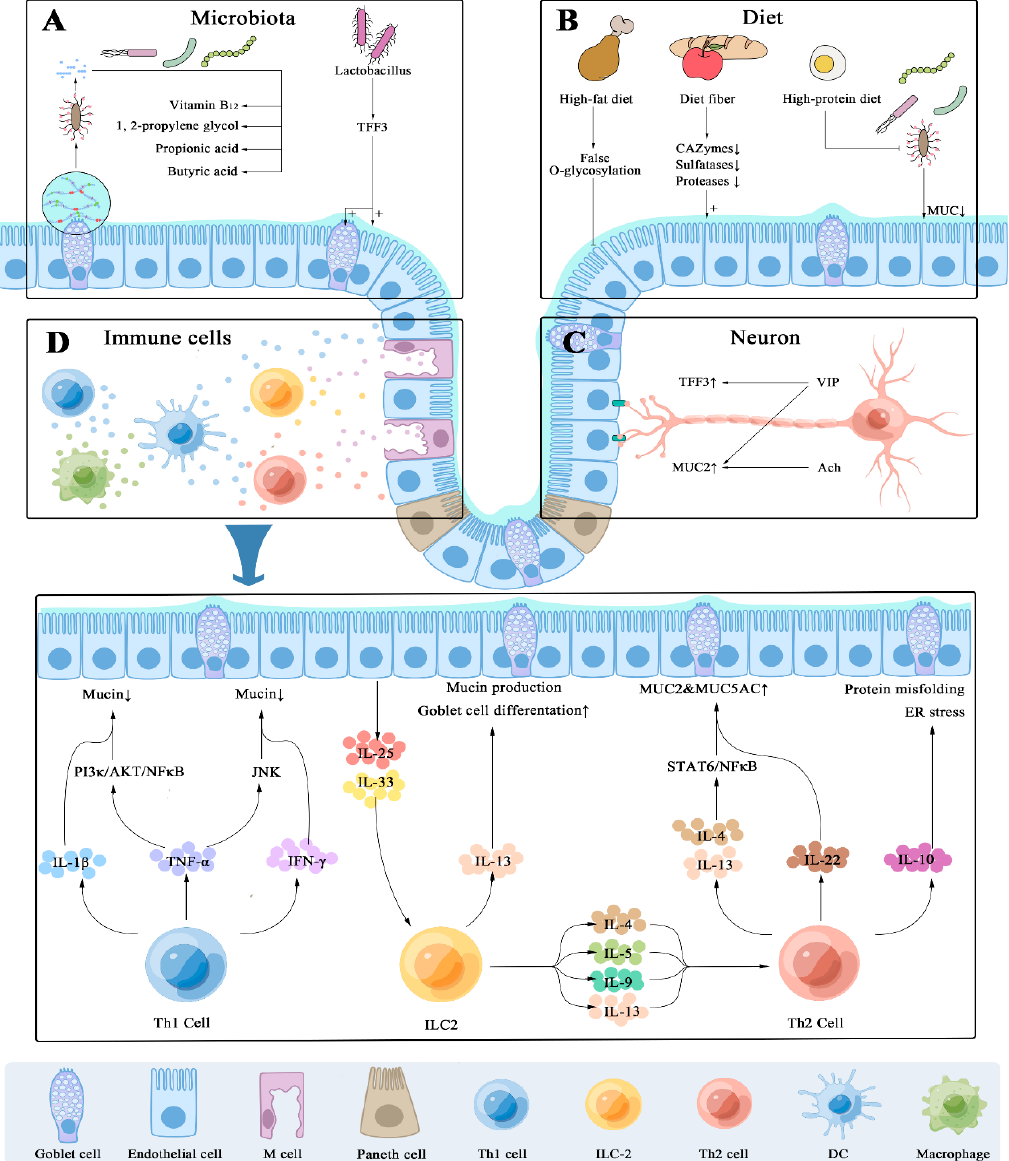
Figure 3. Schematic diagram showing possible factors influencing mucous secretion in the intestinal tract. The secretion of intestinal mucus is mediated by both external and internal factors. These components, such as the microbiome ( A ), food ( B ), neurotransmitters ( C ), and cytokines ( D ), all have a variety of effects on mucus synthesis and secretion.